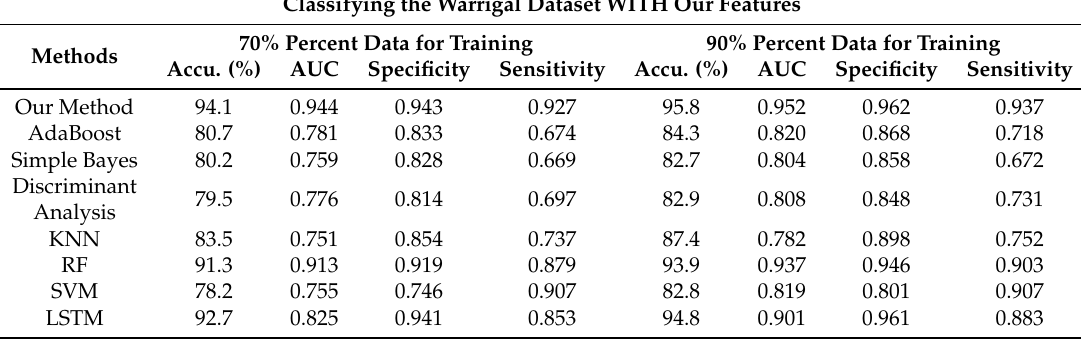
Table 6. A comparison among eight methods on the Warrigal dataset with our feature extraction method. The comparison between the values of accuracy and AUC in Table 5 and this table shows that the performance of all machine learning methods is improved with our feature extraction